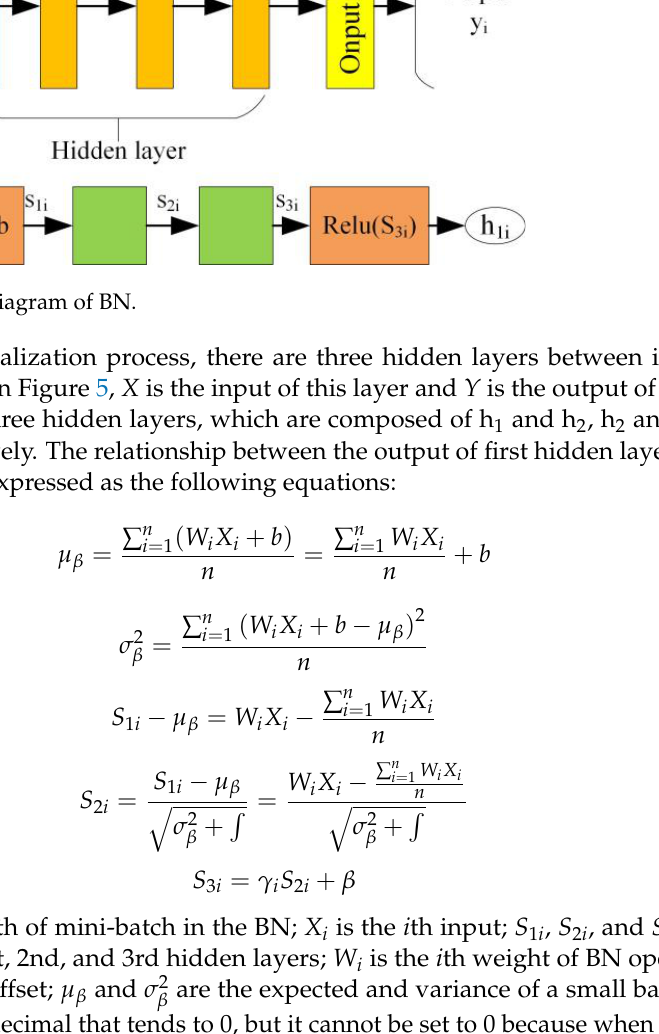
Figure 4. Convolution operation.